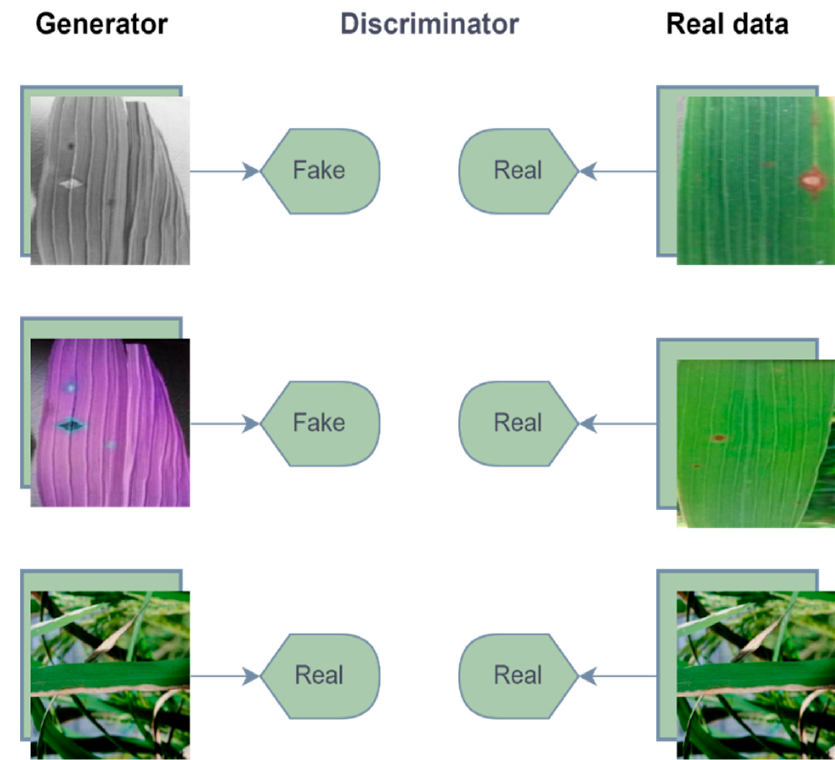
Figure 7. Illustration for intuitive GAN training process.